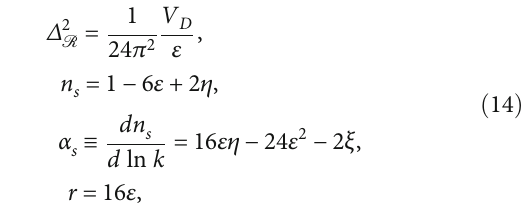
= g = 0 : 62 is shown. During in fl ation, as the in fl aton rolls down from χ 1 2